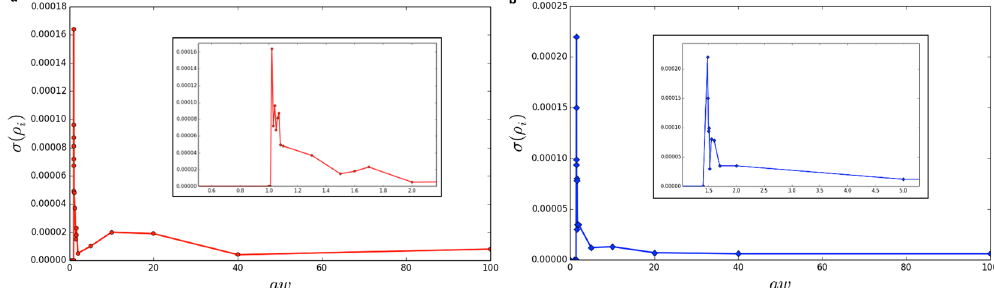
Figure 4. Variance of ρ i , i.e. σ ( ρ i ) in function of aw , for both configurations: ( a ) well mixed and ( b ) regular lattice.